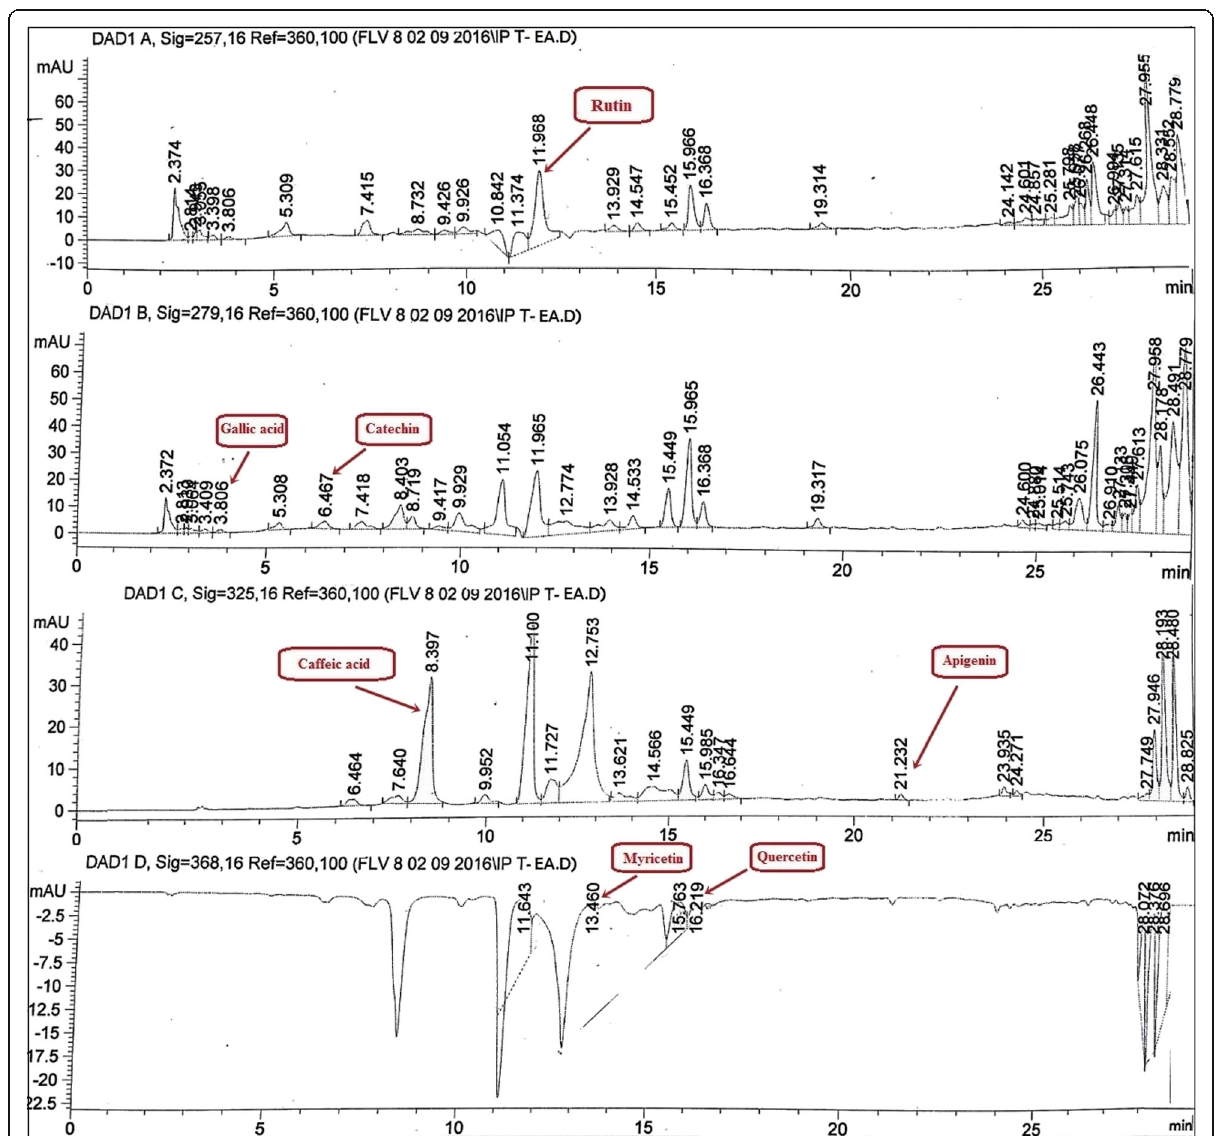
Fig. 1 HPLC-DAD profile of I. batatas tuber ethyl acetate extract (IPT-EA) at different wavelengths. Signal 1: 257 λ , Signal 2:279 λ , Signal 3: 325 λ , Signal 4; 368 λ .Conditions: Mobile Phase A-ACN:MEOH:H2O:AA/ 5:10:85:1, Mobile phase B-ACN:MEOH:AA/ 40:60:1, Injection volume 20 μ l, Flow